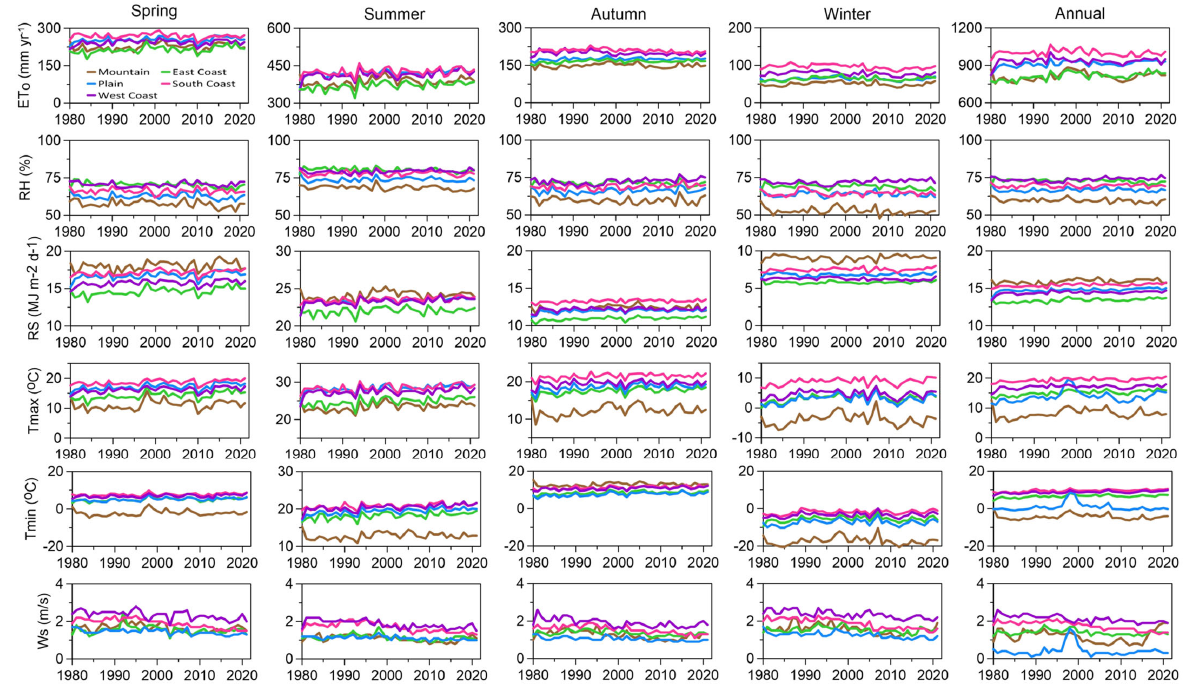
Figure 3. Temporal variation of ET o and meteorological variables on seasonal and annual scales in different geographic conditions (1980–2021).